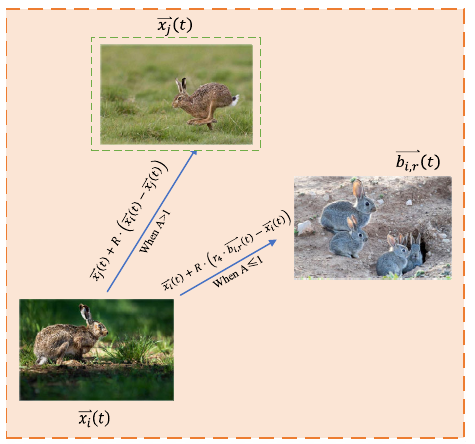
Figure 5. Searching behavior adjustment based on energy factor A.